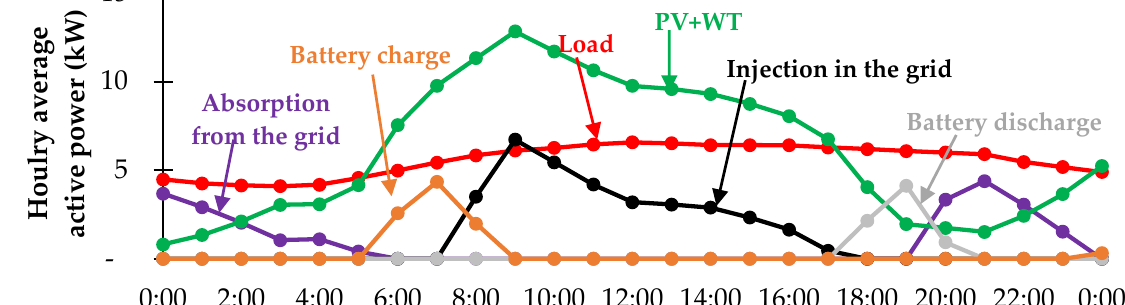
Figure 5. Example of energy flows during a summer day.